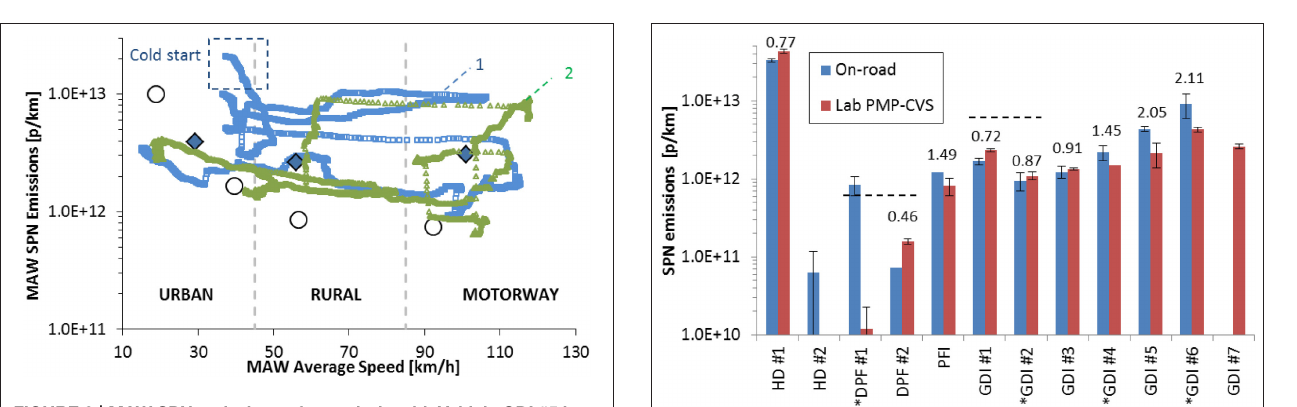
FIGURE 9 | MAW SPN emissions of a road trip with Vehicle GDI #5 in function of the MAW speed. The blue small squares (1) show the first half way of the trip and the small green triangles (2) the return trip. Solid diamonds depict the mean on-road SPN emissions for urban, rural, and motorway driving. White circles depict the laboratory SPN emissions over the four phases of the WLTC.